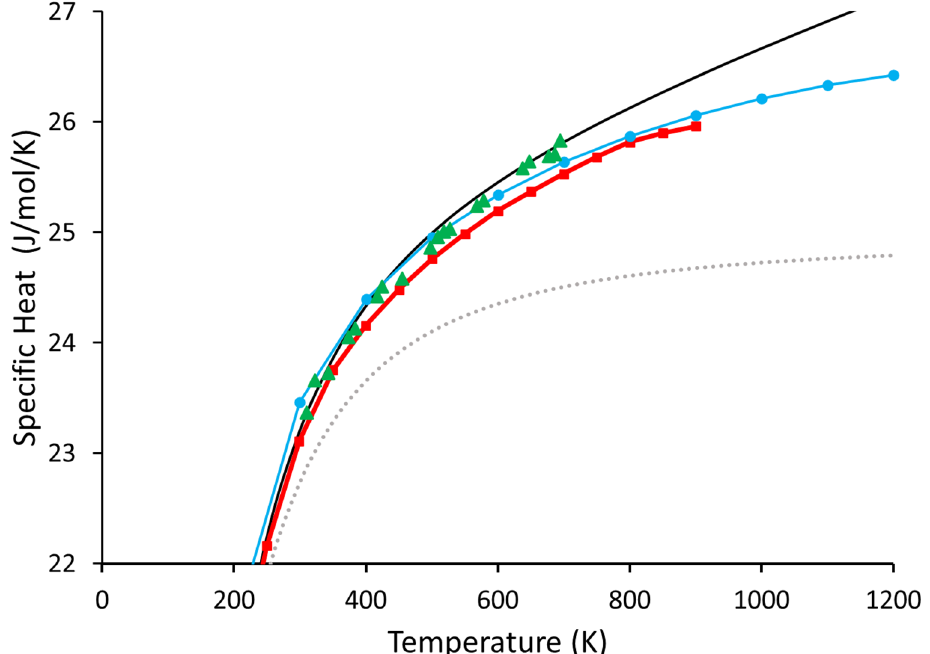
Figure 3. Shown above are our results for the 216- and 64-atom systems of Ge. The solid black line is the 216-atom cell from this work, and the blue circles are the 64-atom cell, also from this work. The grey dotted line represents the calculated values of C v ( T ) (included for reference). The green triangles are the values from reference [30], and the red squares are the quasi-harmonic values calculated in reference [3].